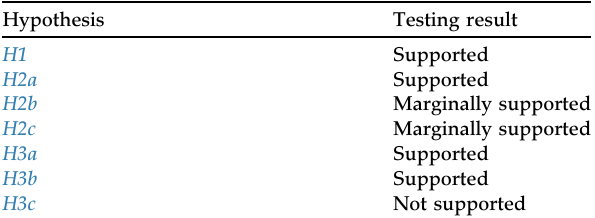
Table 3. Summary of hypothesis